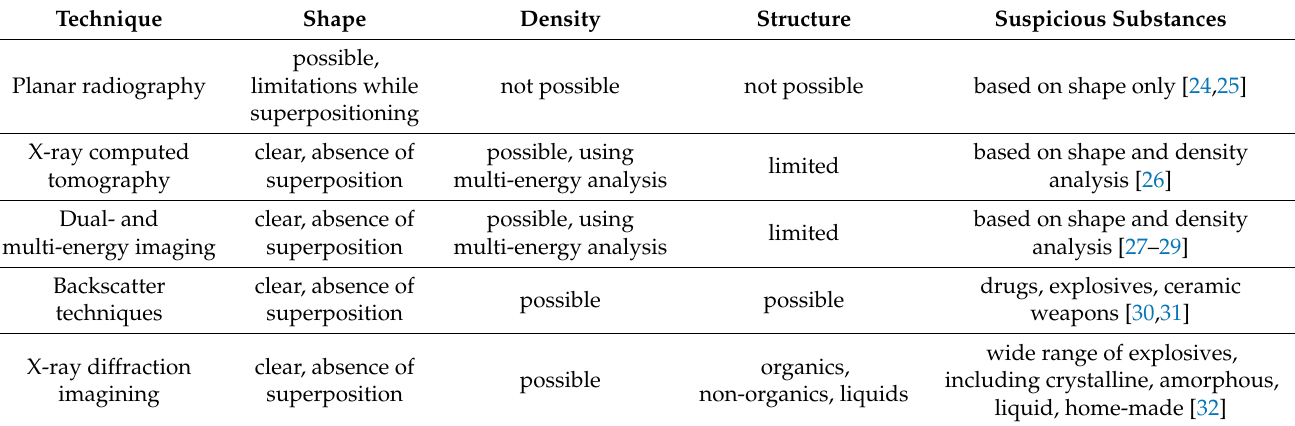
Table 1. Comparison of currently existent X-ray screening methods.